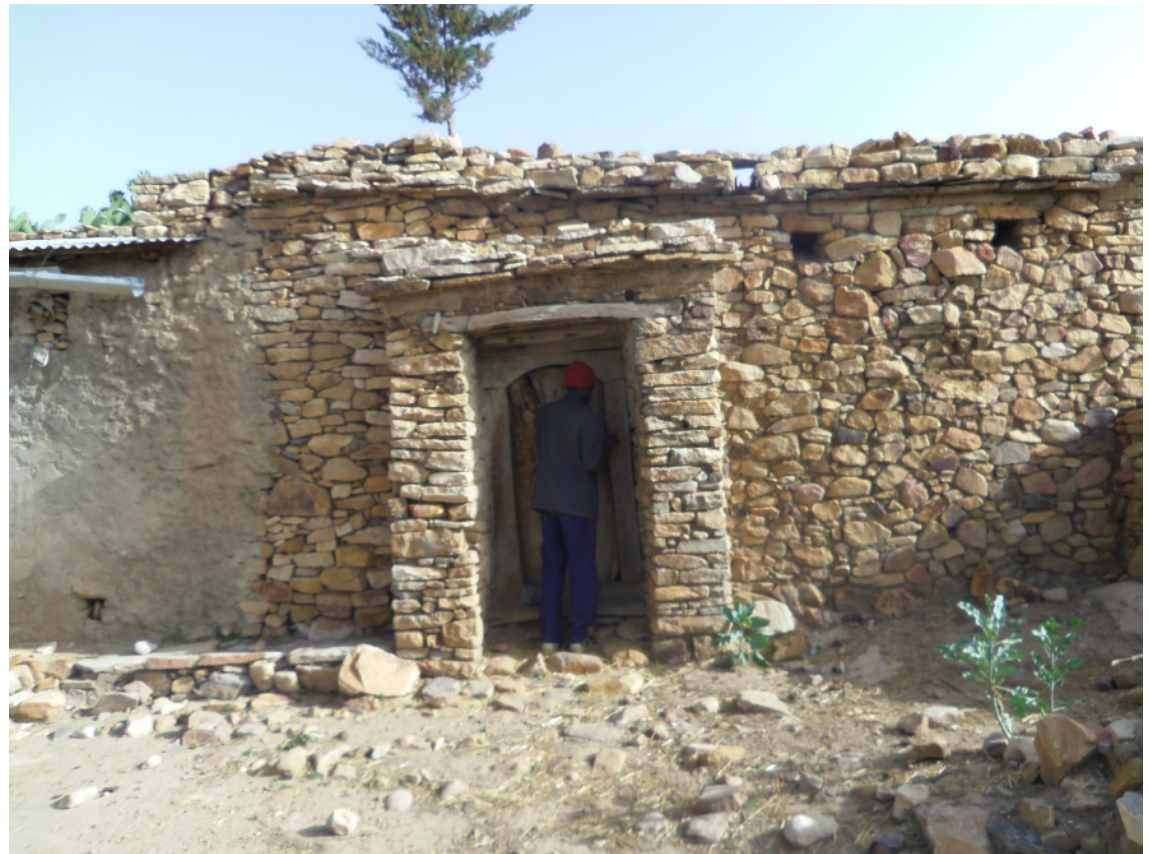
Figure 13. An example of a northern Ethiopian house constructed from